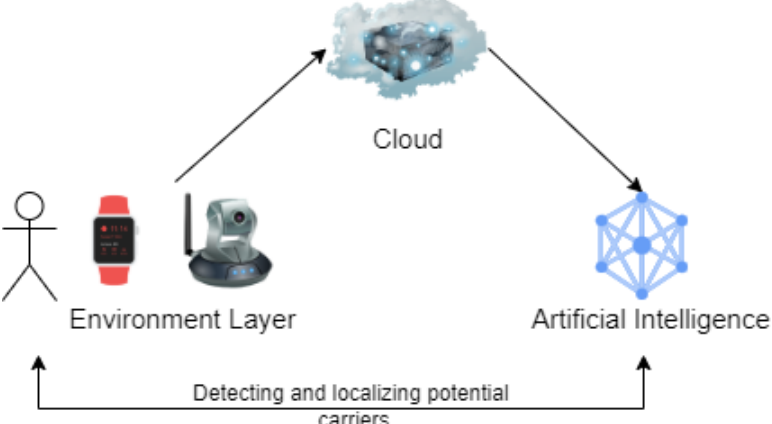
Figure 1. System model for detecting and localizing potential COVID-19 carrier in crowd using the sensor data transmitted by the wearable